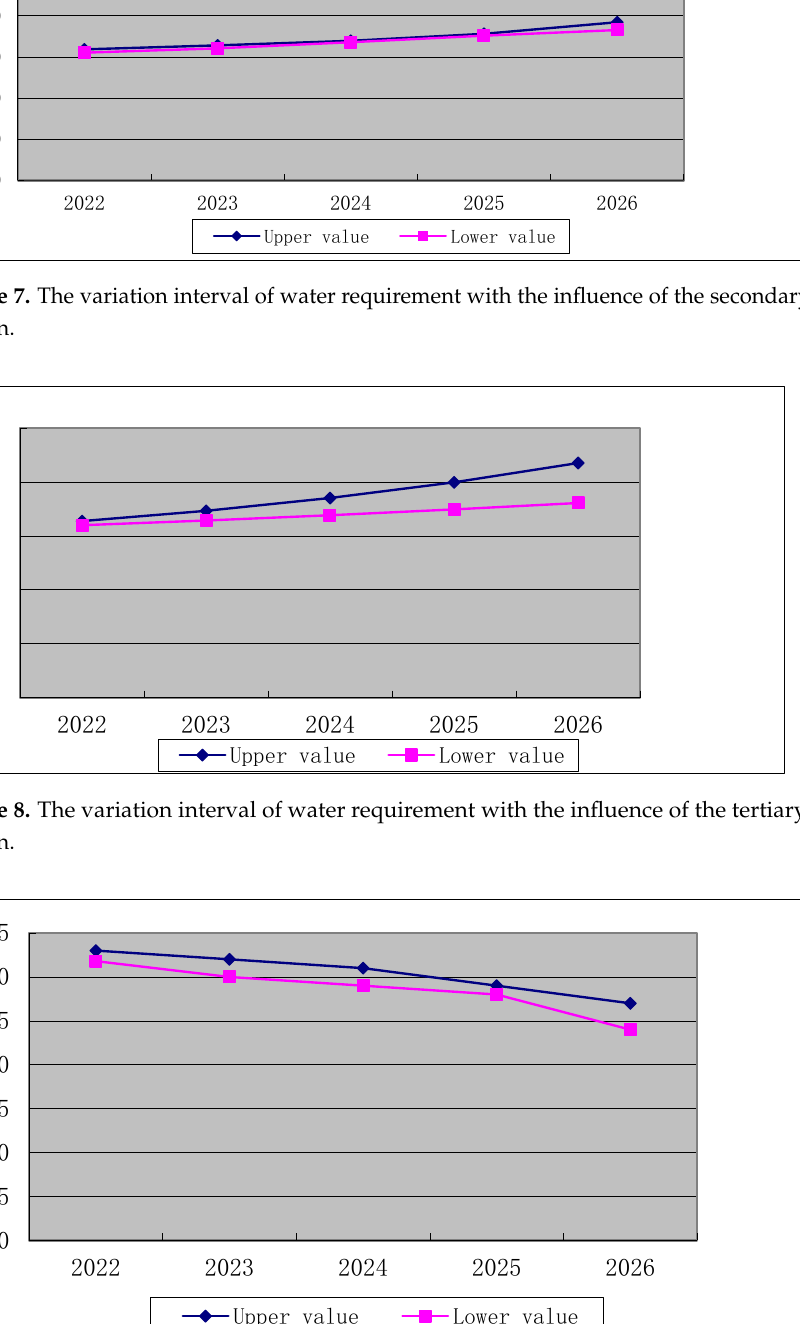
Figure 6. The variation interval of water requirement with the influence of primary industry in Tian- jin.